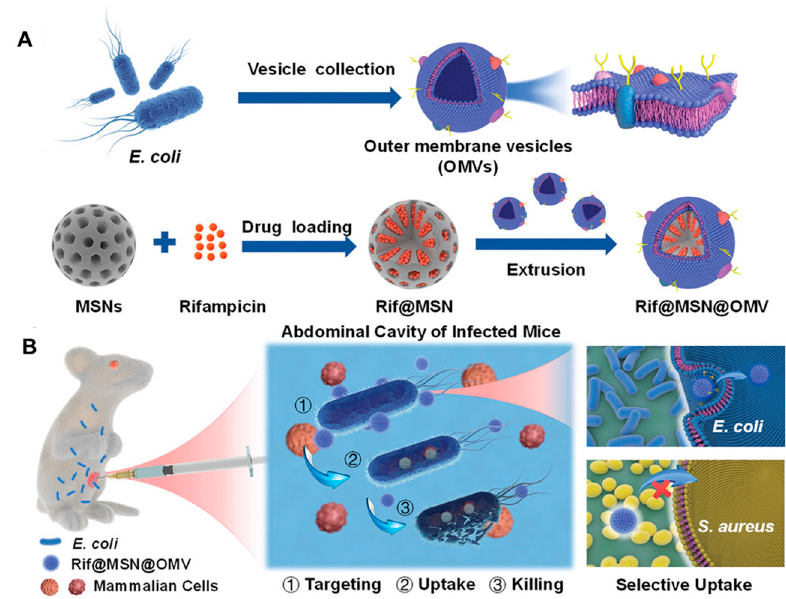
Figure 10. ( A ) Schematic representation of the Rifampicin loaded mesoporous silica nanoparticles coated with bacterial membrane vesiclesand its application in treating bacterial infections in the ( B ) mouse model. [reproduced with permission from Wu et al. [141], copyright 2021 Wiley] .